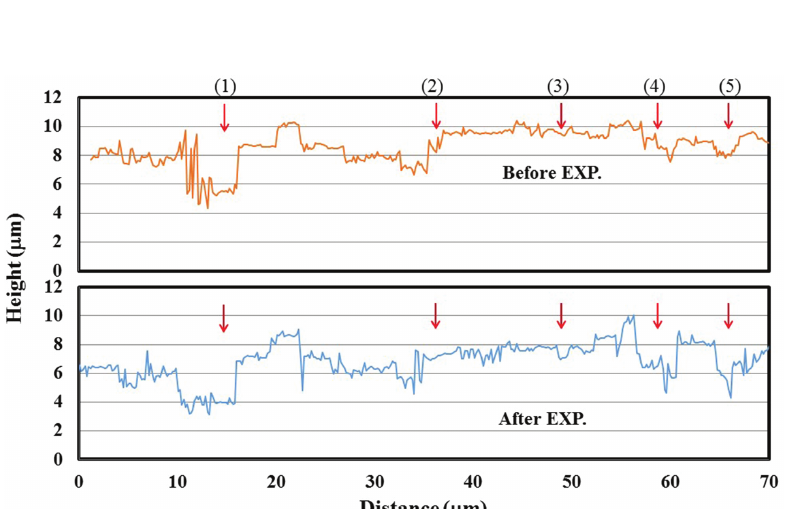
Figure 5: Change in the morphology of Pt surface before and after